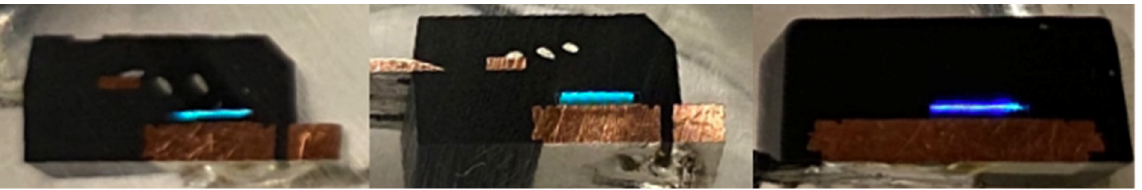
Figure 11. Image of Samples 1, 2 and 3 electrically connected in series and operating at 200 milliamps, showing differences of geometry and color. All samples are shown after second-stage indentations.